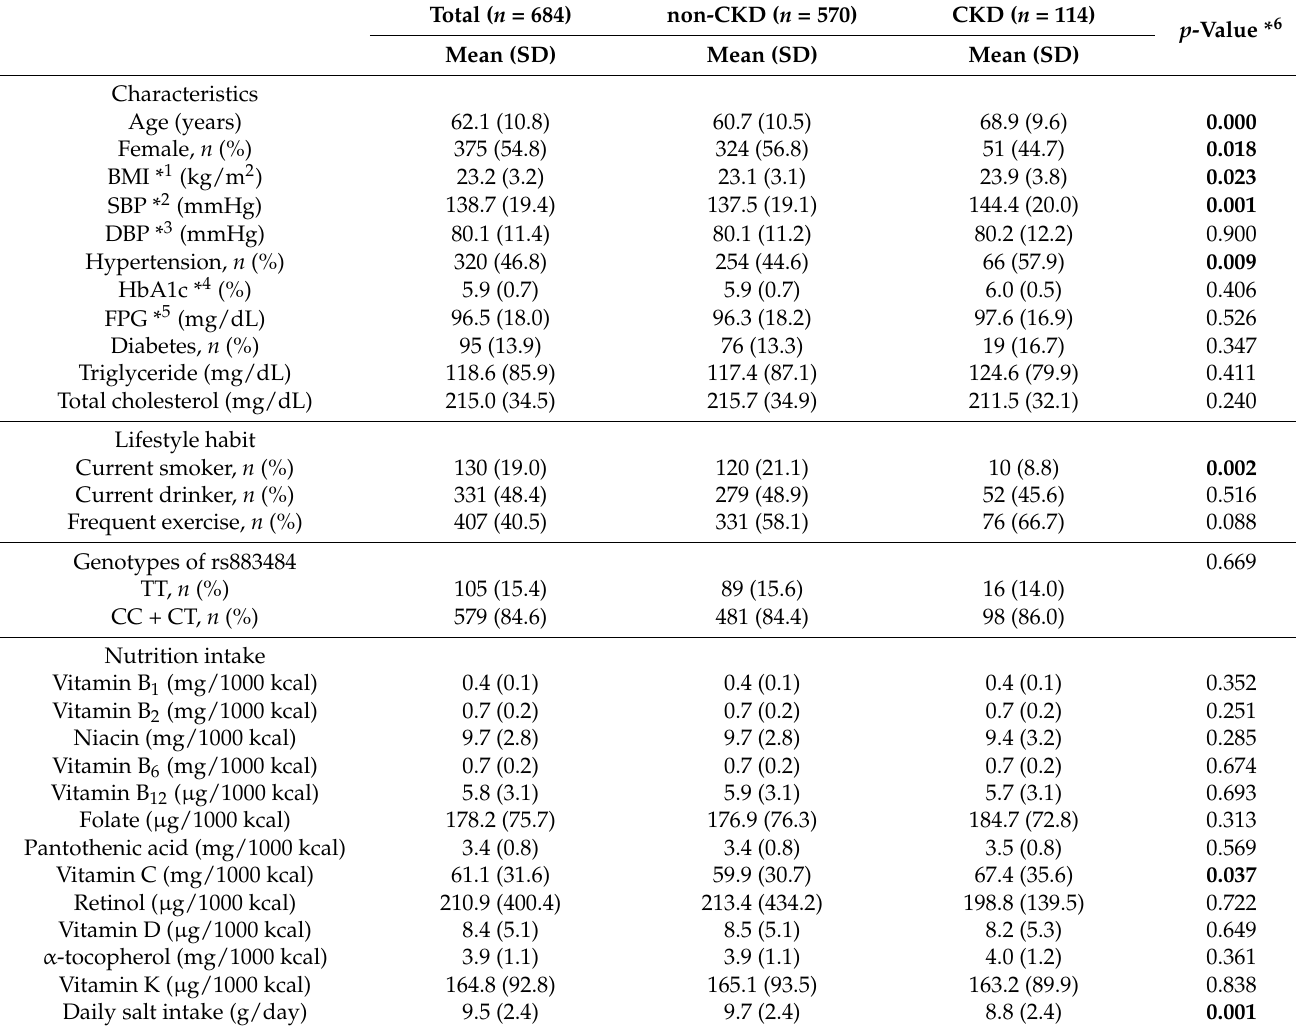
Table 1. Participant characteristics in different CKD